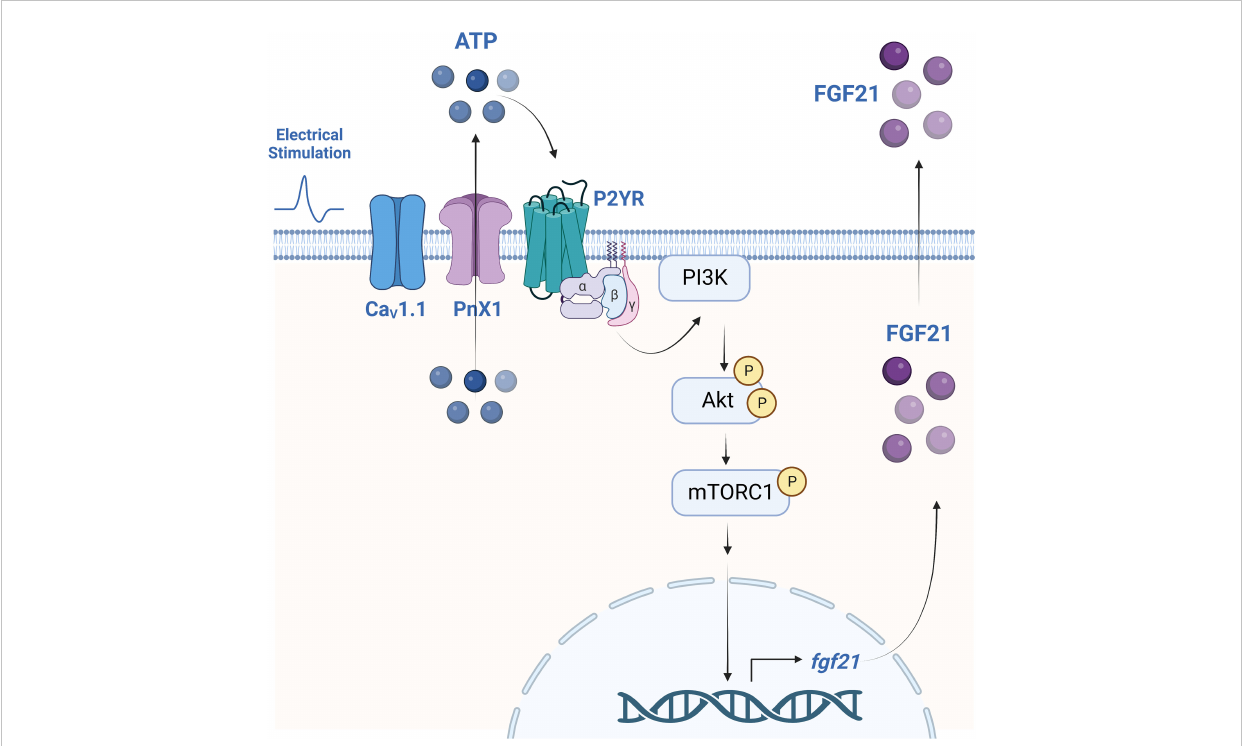
FIGURE 5 Proposed model for the regulation of FGF21 expression and secretion by electrical stimulation, dependent on extracellular ATP signaling and activation of the P2YR/PI3K/Akt/mTORC1 pathway in mouse skeletal muscle. Electrical stimulation is sensed by the dihydropyridine receptor (Ca V 1.1) that, as we previously reported, evokes ATP release from muscle cells through Pannexin-1 hemichannels (PnX1). eATP stimulates P2Y receptors (P2YR) that activate the PI3K/Akt/mTORC1 signaling pathway to promote FGF21 expression and secretion. Created with